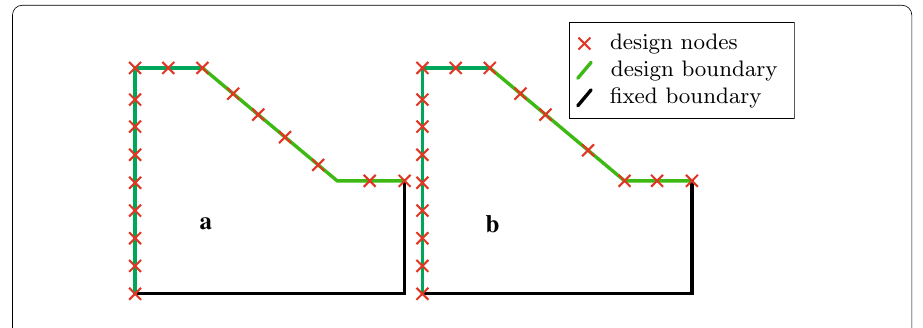
Fig. 5 Two identical target shapes with differing positions of the design nodes. Configuration a as used in [6] and b with two modified nodal positions